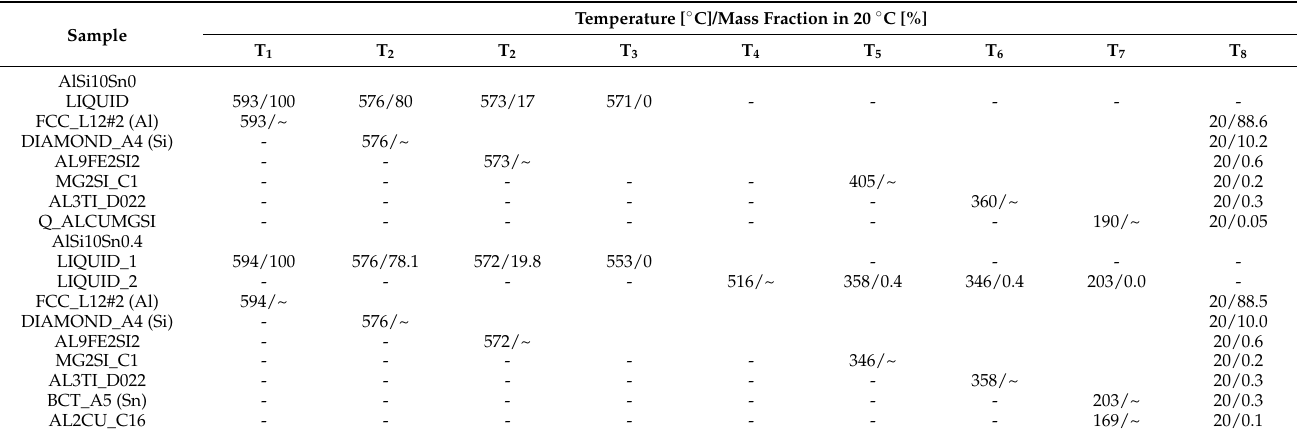
Table 3. Example of TC modelling for AlSi10 and AlSi10Sn0.4 alloys.